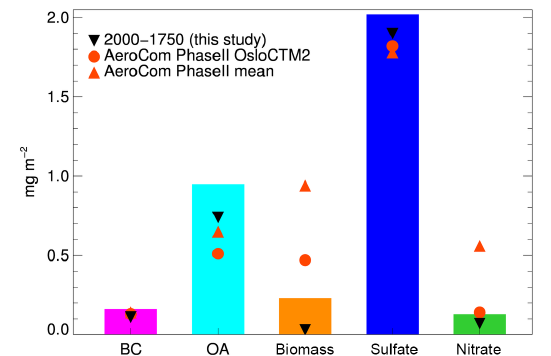
Figure 7. Change in anthropogenic aerosol load over the period from 1750 to 2014 using CEDSv16 emissions. Black symbols show the 1750 to 2000 difference and red symbols show multi-model mean and Oslo CTM2 results from the AeroCom II experiments (Myhre et al.,